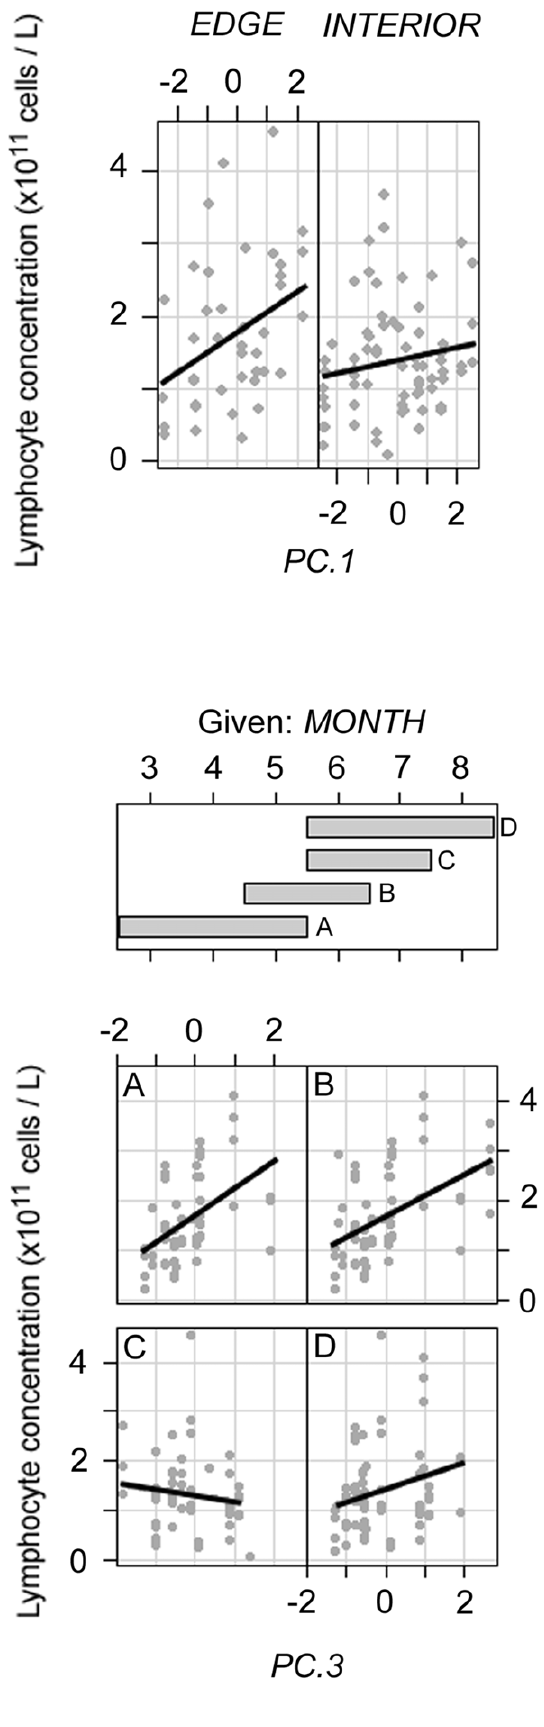
Figure 3. Conditioning plots of PC.1 given EDGE (above) and PC.3 given MONTH (below) for female lymphocyte concentra- tion. Overlap is